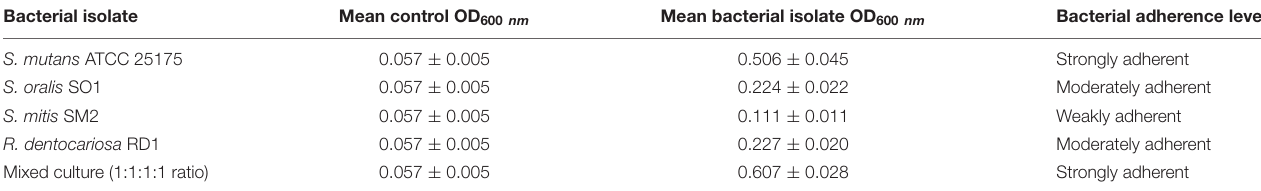
TABLE 1 | Biofilm adherence levels of S. mutans ATCC 25175, S. oralis SO1, S. mitis SM2, and R. dentocariosa RD1 oral isolates, in pure and mixed cultures.